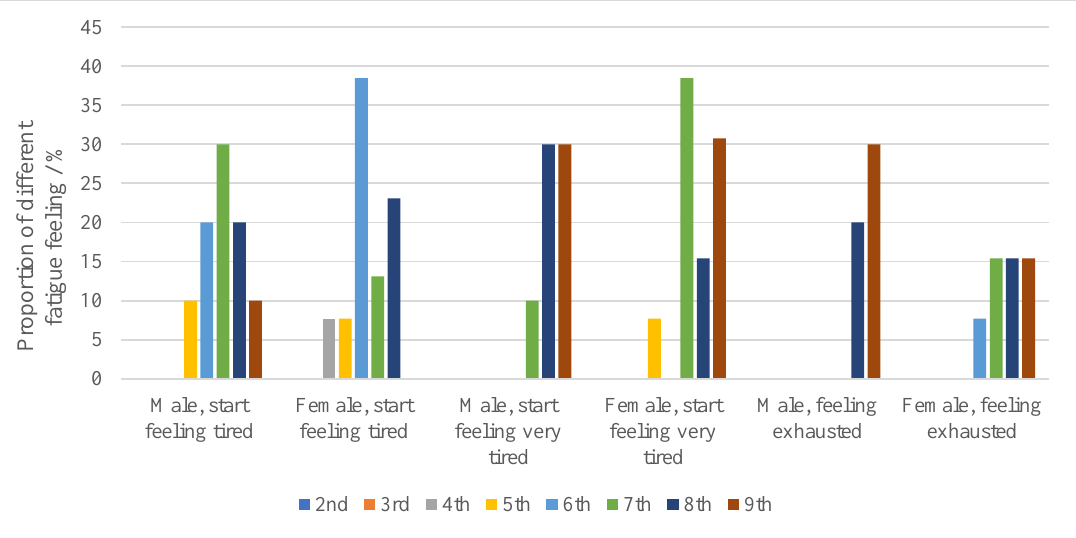
Figure 15. Fatigue feeling survey during walking upstairs of the middle-aged